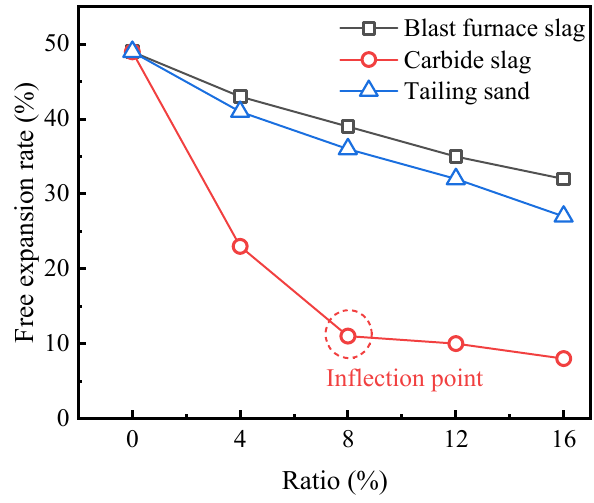
Figure 3. Free expansion rate of different waste residues soils.